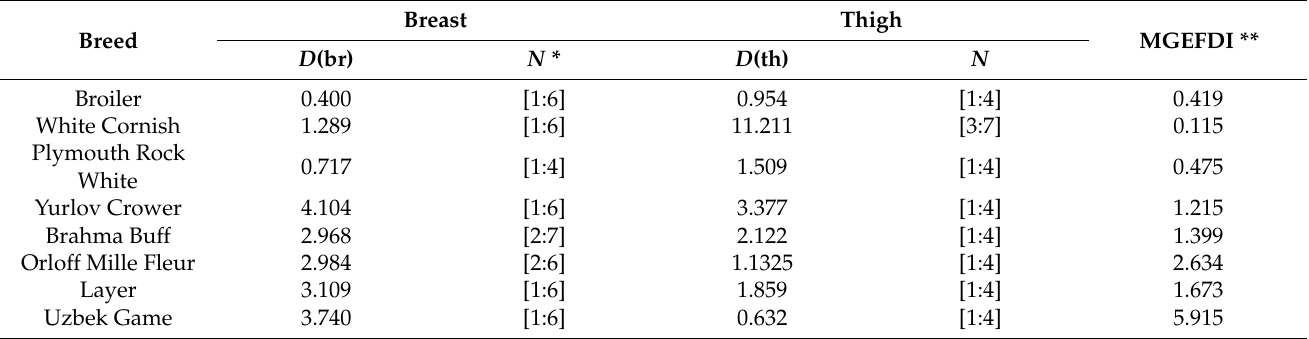
Table 4. Estimation of fractal dimension coefficients D in the breast ( D (br)) and thigh ( D (th)) muscles.